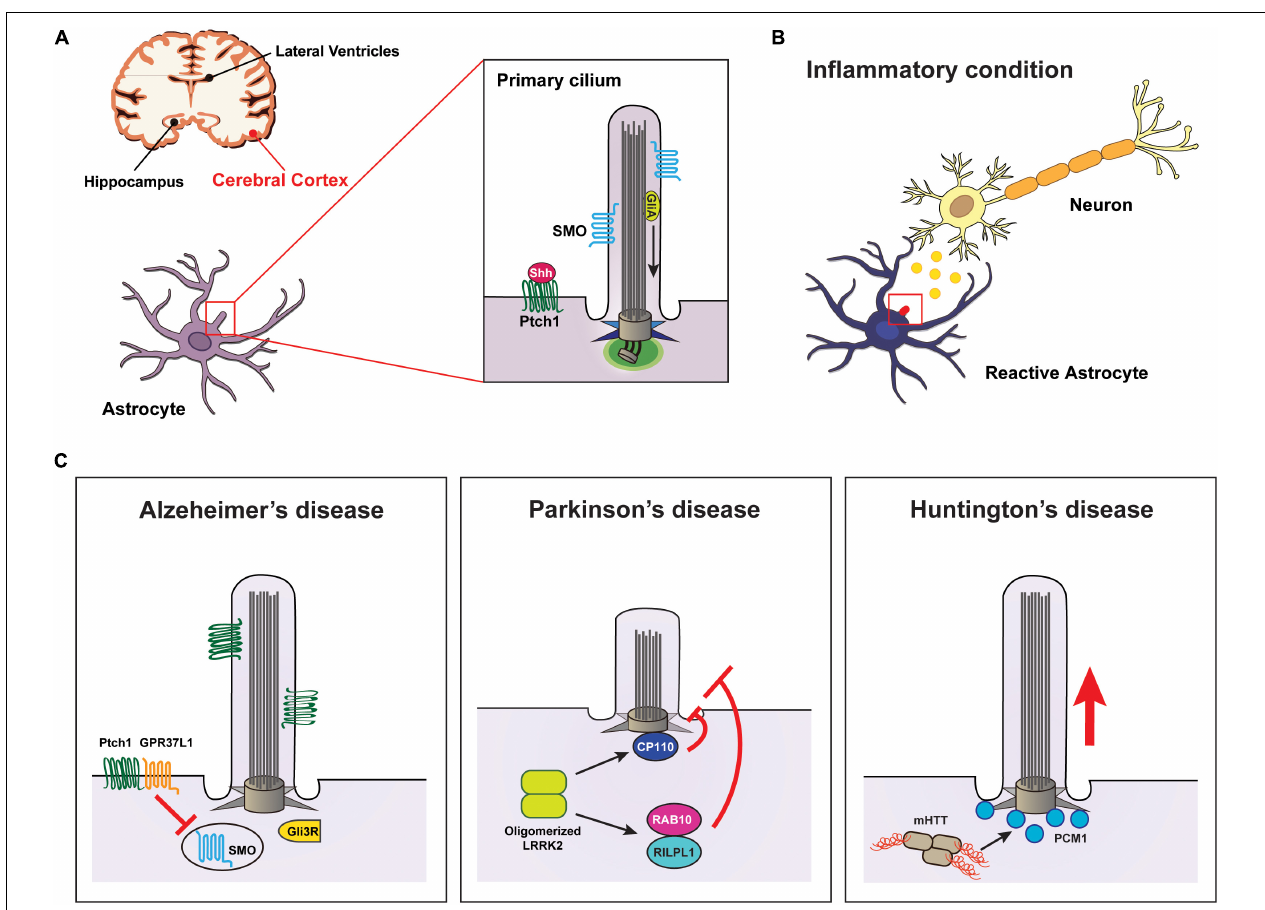
FIGURE 1 | Signaling through the primary cilia in astrocytes is associated with neurodegenerative diseases. (A) Diagram showing the primary cilia of astrocytes associated with diseases occurring in the cerebral cortex. (B) Neuroinflammation affects Shh signal transduction through the primary cilia in astrocytes. (C) Examples of neurodegenerative diseases involved in impairments of primary cilia in astrocytes. Elevated A β attenuates Shh signaling in astrocyte cilia, leading to Alzheimer’s disease. Defects in LRRK2 cause Parkinson’s disease by inhibiting astrocyte cilia formation by preventing the removal of CP110 from the ciliary base or by inducing a complex of RILPL1 and RAB10. Huntington’s disease results from mutated HTT-induced PCM1 accumulation at the ciliary base of